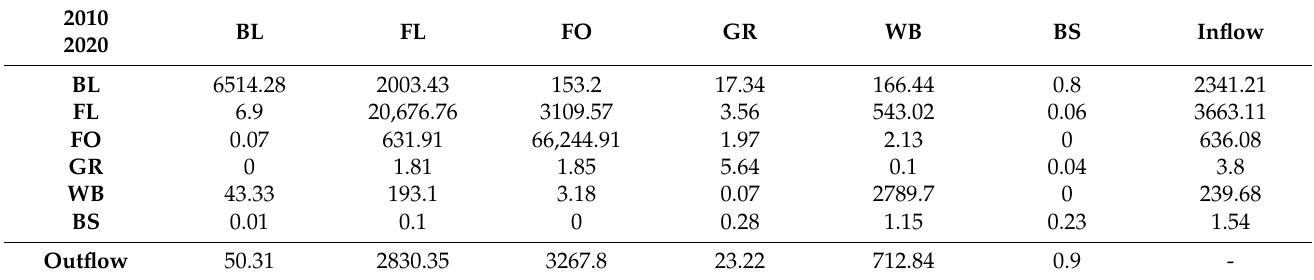
Table 6. Transfer matrix of land use change in Zhejiang Province from 2010 to 2020 (km 2